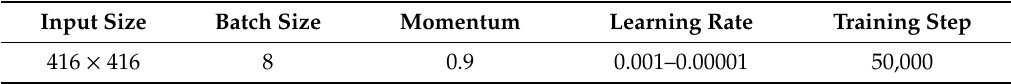
Table 4. The initialization parameters of